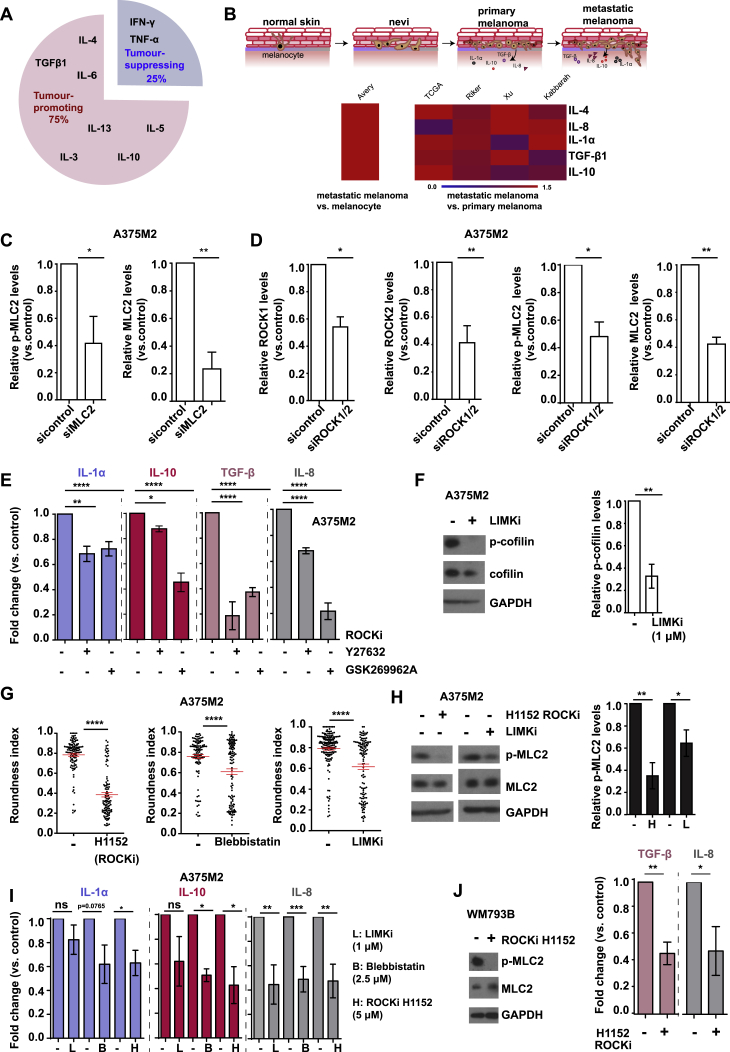
Myosin II Activity in Melanoma Cells Favors Secretion of Immunomodulatory Factors, Related to Figure 2(A) Chart pie shows the factors influencing the balance toward tumor-promoting inflammation versus tumor-suppressive inflammation in CM A375M2.(B) (Top) Schematic illustrates secreted factors in melanoma progression and (bottom) heatmap shows fold change for mRNA levels of IL-4, IL-8, IL-1α, TGF-β and IL-10 in metastatic melanoma versus melanocyte and metastatic versus primary melanoma samples. Raw data were obtained from TCGA and GEO databases.(C) Relative p-MLC2 and MLC2 levels in A375M2 cells after MLC2 knockdown.(D) Relative ROCK1, ROCK2, p-MLC2 and MLC2 levels in A375M2 cells after ROCK1/2 knockdown.(E) Secreted levels of IL-1α, IL-10, TGF-β and IL-8 in CM A375M2 cells after treatment with Y27632 (10 μM) or GSK269962A (5 μM) for 48h (n ≥ 3). Data are presented as fold change versus the control.(F) (Left) Representative immunoblot for p-cofilin and (right) relative p-cofilin levels, in A375M2 cells after treatment with LIMKi 3 (1μM) for 48h (n = 3).(G) Roundness index of A375M2 cells seeded on top of collagen I, treated with H1152 (5μM), Blebbistatin (2.5μM) or LIMKi 3 for 48h (n = 3).(H) (Left) Representative immunoblots for p-MLC2 and (right) quantification of p-MLC2 levels, in A375M2 cells treated with H1152 or LIMKi 3 for 48h (n = 3).(I) Secreted levels of IL-1α, IL-10 and IL-8 in CM A375M2+H1152, CM A375M2+Blebbistatin or CM A375M2+LIMKi 3. Data are presented as fold change versus the control (n ≥ 3 for IL-10 and IL-8 and n ≥ 2 for IL-1α).(J) (Left) Representative immunoblot for p-MLC2 levels in WM793B cells and (right) secreted levels for TGF-β and IL-8 by WM793B cells, after treatment with H1152 (5 μM) for 48h (n ≥ 3).(C-J) Graphs and dot blots show mean ± SEM.(C, D, and F–J) t test. (E) One-way ANOVA with Tukey post hoc test.ns p > 0.05,∗p < 0.05,∗∗p < 0.01,∗∗∗p < 0.001,∗∗∗∗p < 0.0001.